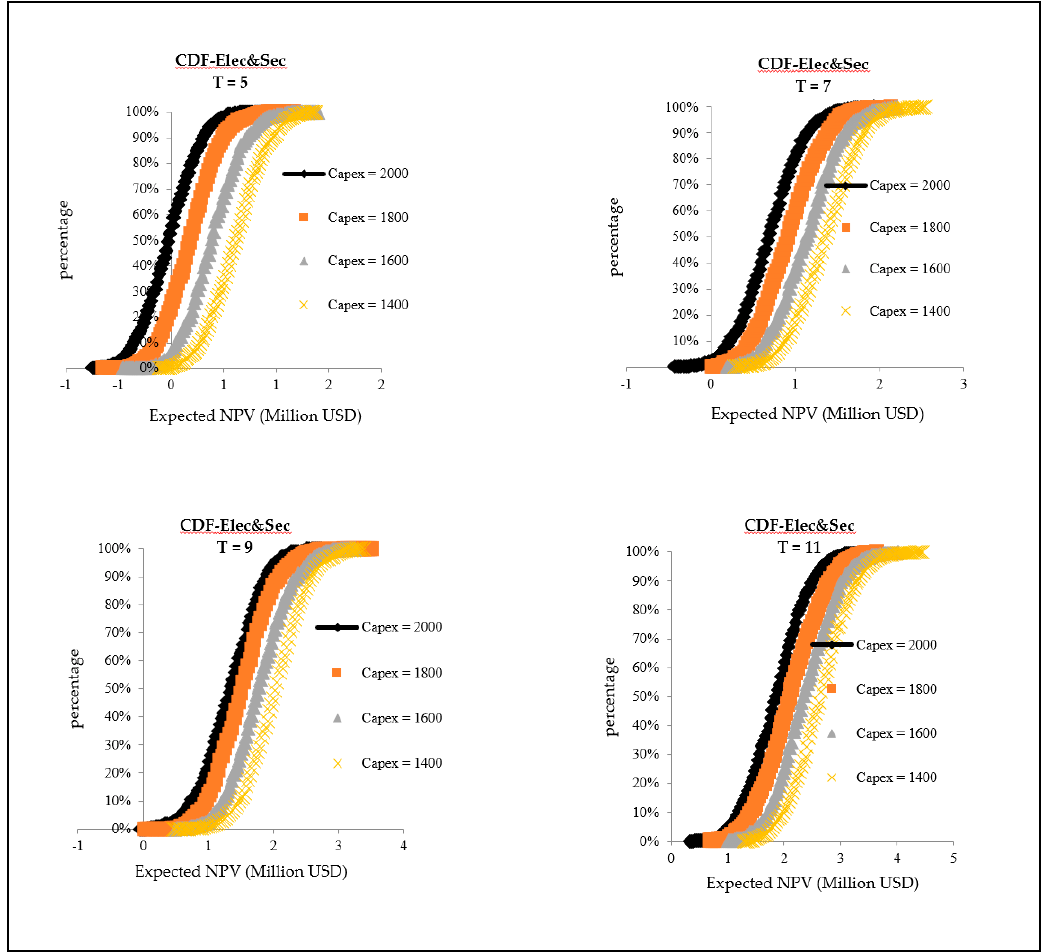
Figure 11. The probability distribution of the NPV by 30% reduction of the investment cost (source: authors calculation, using Crystal Ball software).